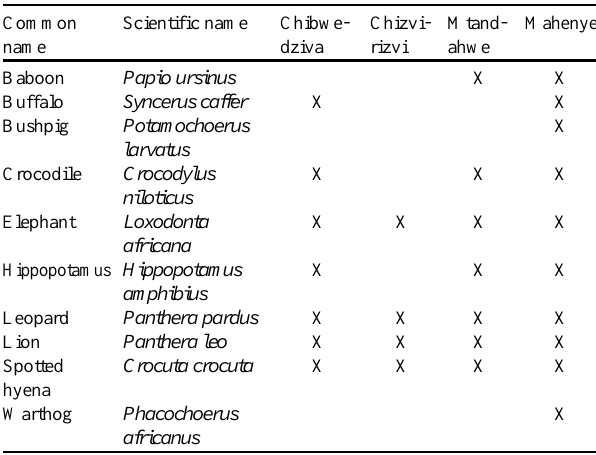
Table 6 . Animal species that were recorded as being involved in human-wildlife conflicts in the four study communities adjacent to the northern Gonarezhou National Park, Zimbabwe between 2000 and 2010. X = recorded to have been involved in conflict with local